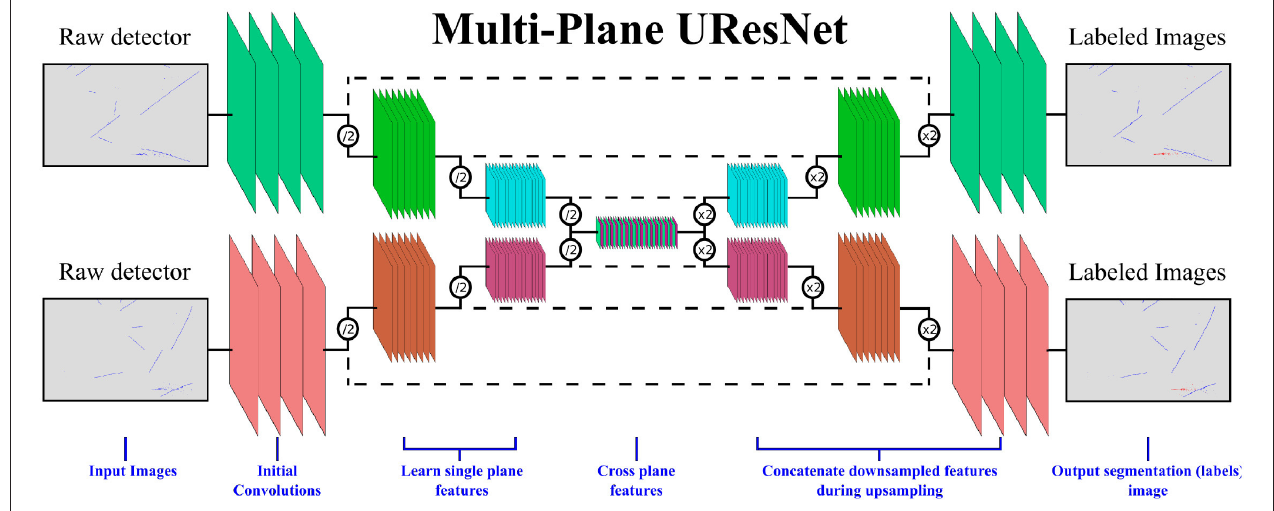
FIGURE 6 | A representation of the multi-plane UResNet architecture. Only two of the three planes are shown in this image for clarity.